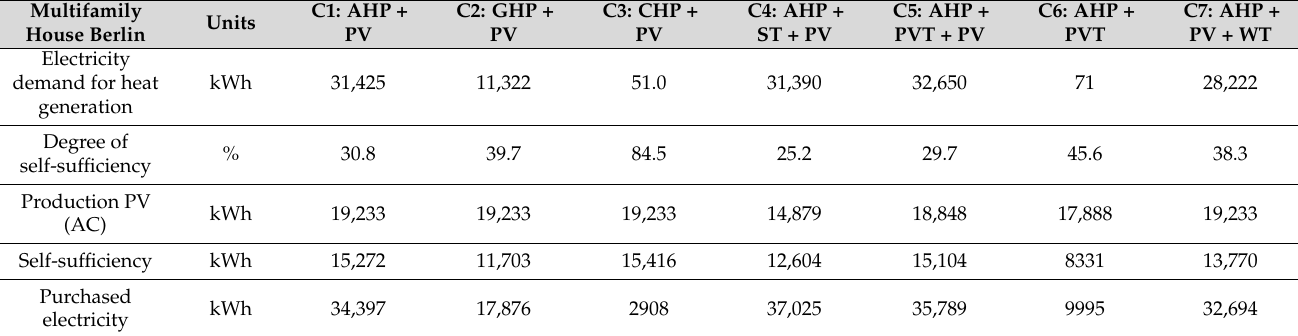
Table 3. Results of the Polysun simulation for the multi-family house in Berlin,